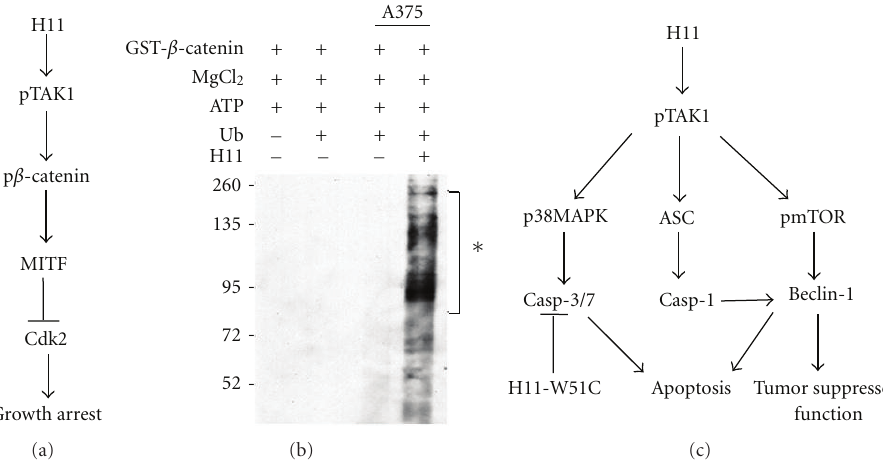
Figure 3: H11/HsPB8 causes growth arrest and melanoma cell death through distinct TAK1-regulated pathways. (a) Schematic representation of H11/HspB8-induced growth arrest involves β -catenin phosphorylation by the activated TAK1. (b) GST- β -catenin phosphorylated when mixed with cell extracts containing H11/HspB8-activated TAK1 is ubiquitylated causing its degradation ( ∗ ). Ubiquitylation is not seen when GST- β -catenin is mixed with cell extracts that lack H11/HspB8 and therefore pTAK1. (c) H11/HspB8 induces di ff erent death pathways in the genetically diverse melanoma cells A375 and A2058 that initiate with TAK1 activation. In A375 cells, the TAK1/p38MAPK pathway activates caspase-3/7 to cause apoptosis. In A2058 cells, the TAK1/p38MAPK pathway activates caspase- 3, but TAK1 also activates caspase-1 through ASC upregulation and upregulates Beclin-1 through mTOR phosphorylation at S2481 (pmTORS2481). Caspase-1 cleaves Beclin-1 to promote apoptosis, but Beclin-1 also contributes to cell death through still unknown tumor suppressor functions. The W51C mutant of H11/HspB8 has dominant-negative activity. It inhibits the death-inducing potential of the wild- type H11/HspB8 by inhibiting caspase activation through the activation of the B-Raf/MEK/ERK pathway